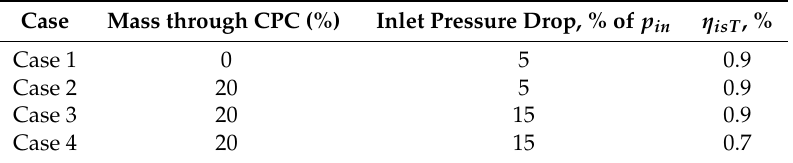
Table 3. Values of the parameters for the first stage of simulations.